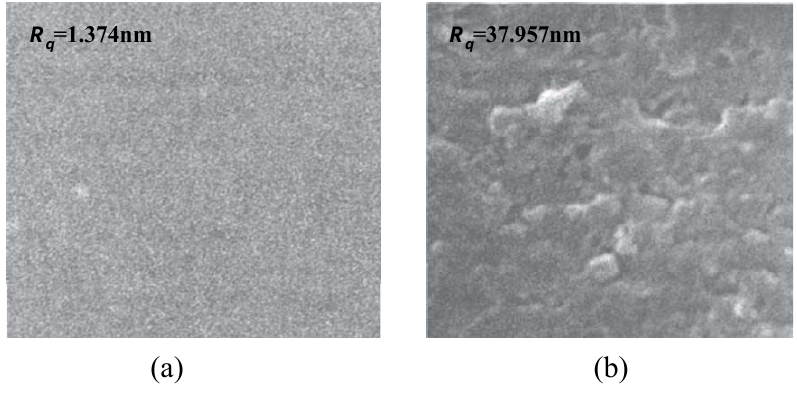
Figure 7. The SEM picture of (a) uncoated-surface, and (b) coated-surface of the delay line.